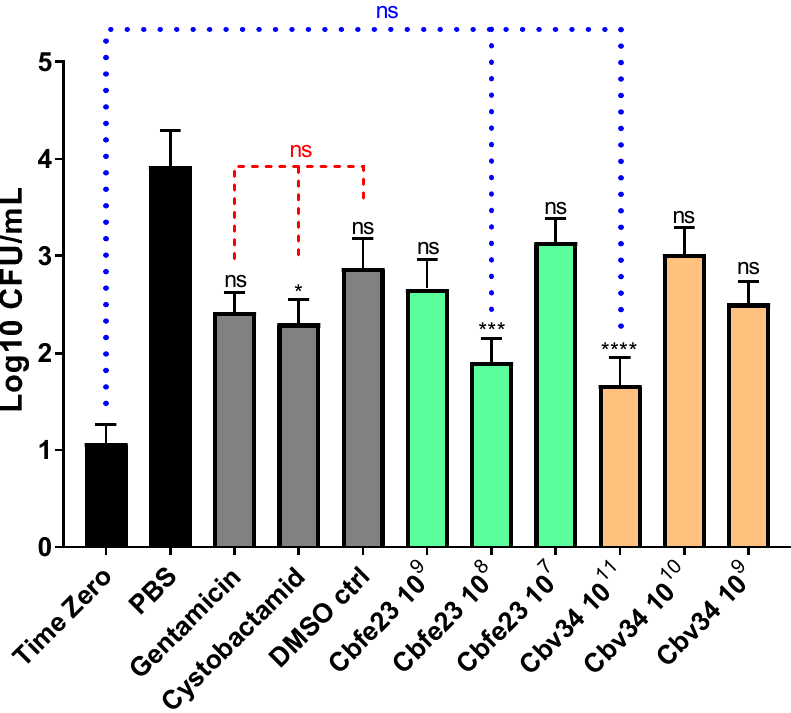
Figure 9. Antibacterial effect of OMVs against intracellular S. aureus after 24 h of treatment. Mean ± SEM, n = 3–4 independent experiments. Significance was defined in relation to the PBS control as ns = not significant, * p -value < 0.05, *** p -value < 0.0005 and **** p -value < 0.0001. Red dashed lines represent the comparison between gentamicin 10 μ g/mL, cystobactamid 10 μ g/mL and the DMSO control = not significant. Blue dotted lines represent the comparison between the time zero (2 h bacterial uptake), Cbfe23 10 8 particles/mL and Cbv34 10 11 particles/mL.